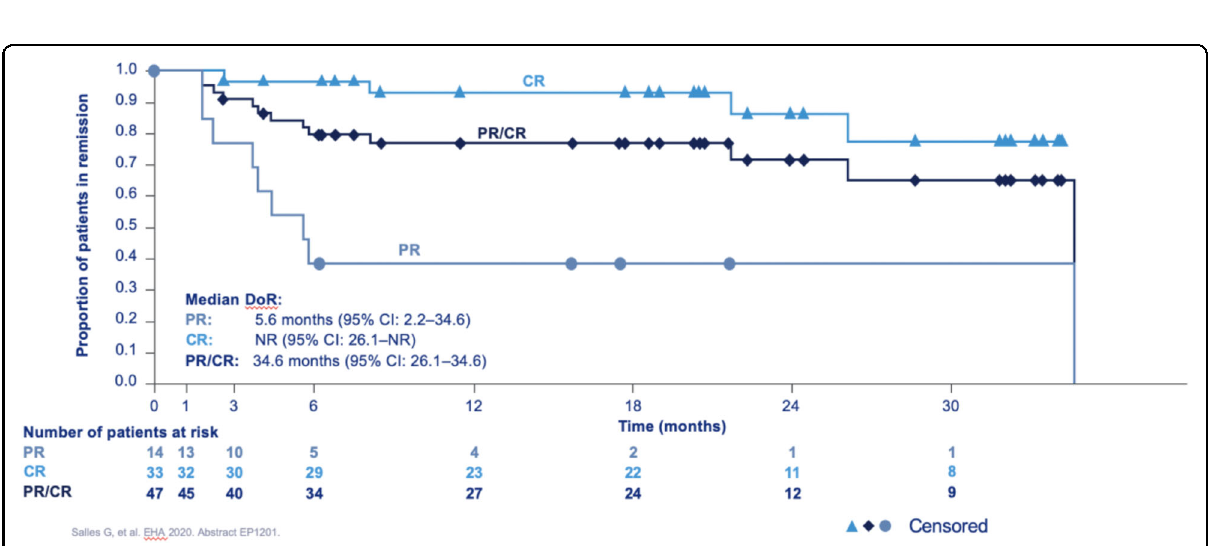
Fig. 4 Duration of response in the L-MIND study (courtesy of Morphosys). DOR correlates with response in DLBCL with NR in those with a CR and only 5.6 months for those with a